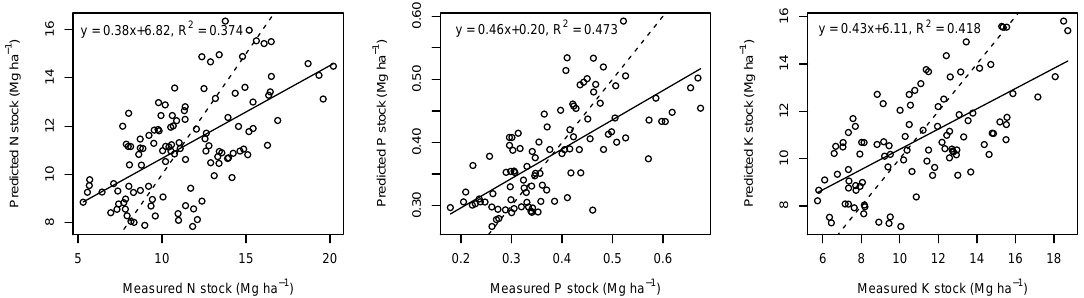
Figure 3. Cross-validation of OK interpolation for soil N, P, and K